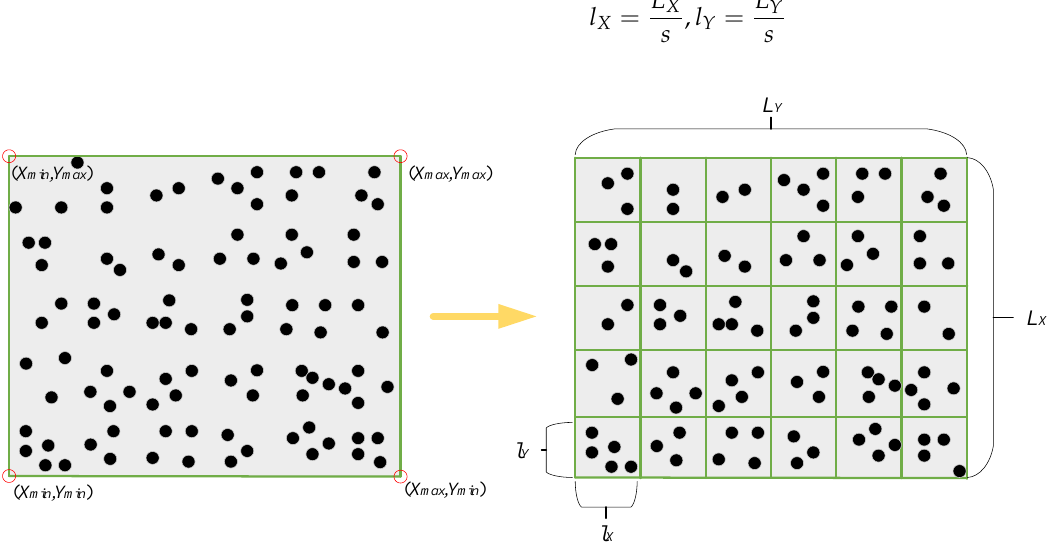
Figure 6. Schematic diagram of meshing point cloud data.